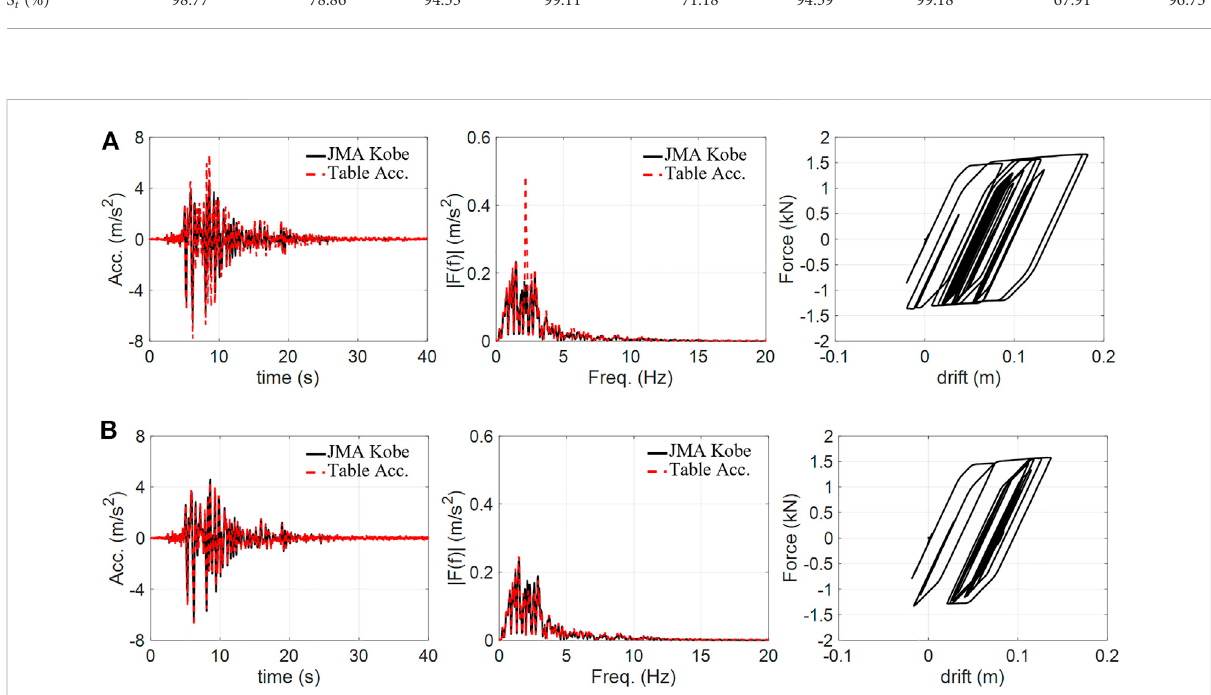
FIGURE 10 Numerically disturbed experiment with a nonlinear structure and 80% JMA Kobe motion: (A) IBC and (B) NSBC. (Left: time-history table acceleration, middle: Fourier amplitude spectra of table acceleration, right: structural hysteresis.)